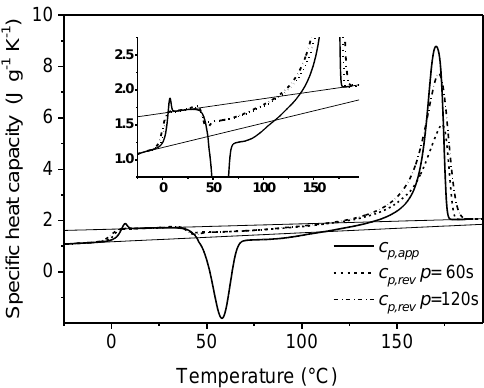
Figure 1. Apparent specific heat capacity ( c p,app ) by standard differential scanning calorimetry (DSC) and reversing-specific heat capacity ( c p,rev ) of poly(3-hydroxybutyrate) (PHB) measured after cooling from the melt at 200 K min −1 at modulation periods p = 60 s and 120 s ( A T = 1.0 K, q = 2 K min −1 ). The thin solid lines are the solid- and liquid-specific heat capacities, as taken from [22]. The inset is an enlargement of the Figure in the cold crystallization region. (Reprinted (adapted) with permission from [35]. Copyright (2012) American Chemical Society).